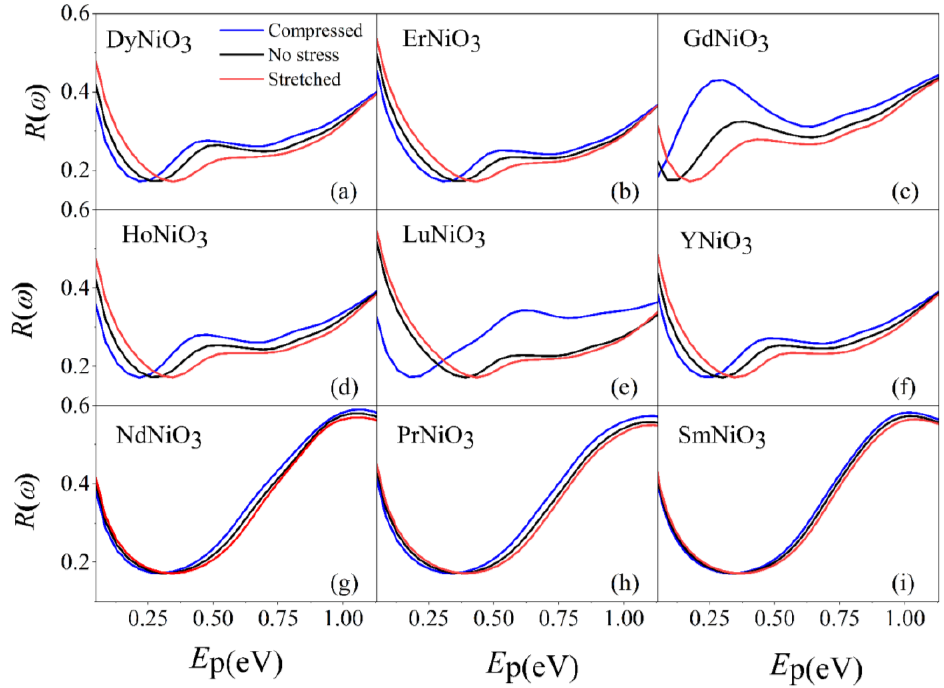
Figure 4. Reflectivity of DyNiO 3 ( a ), ErNiO 3 ( b ), GdNiO 3 ( c ), HoNiO 3 ( d ), LuNiO 3 ( e ), YNiO 3 ( f ), NdNiO 3 ( g ), PrNiO 3 ( h ), and SmNiO 3 ( i ). The optical properties of RE NiO 3 under different strains can be explained as follows. The compression of RE NiO 3 causes a decrease in the bond length of Ni-O-Ni and an